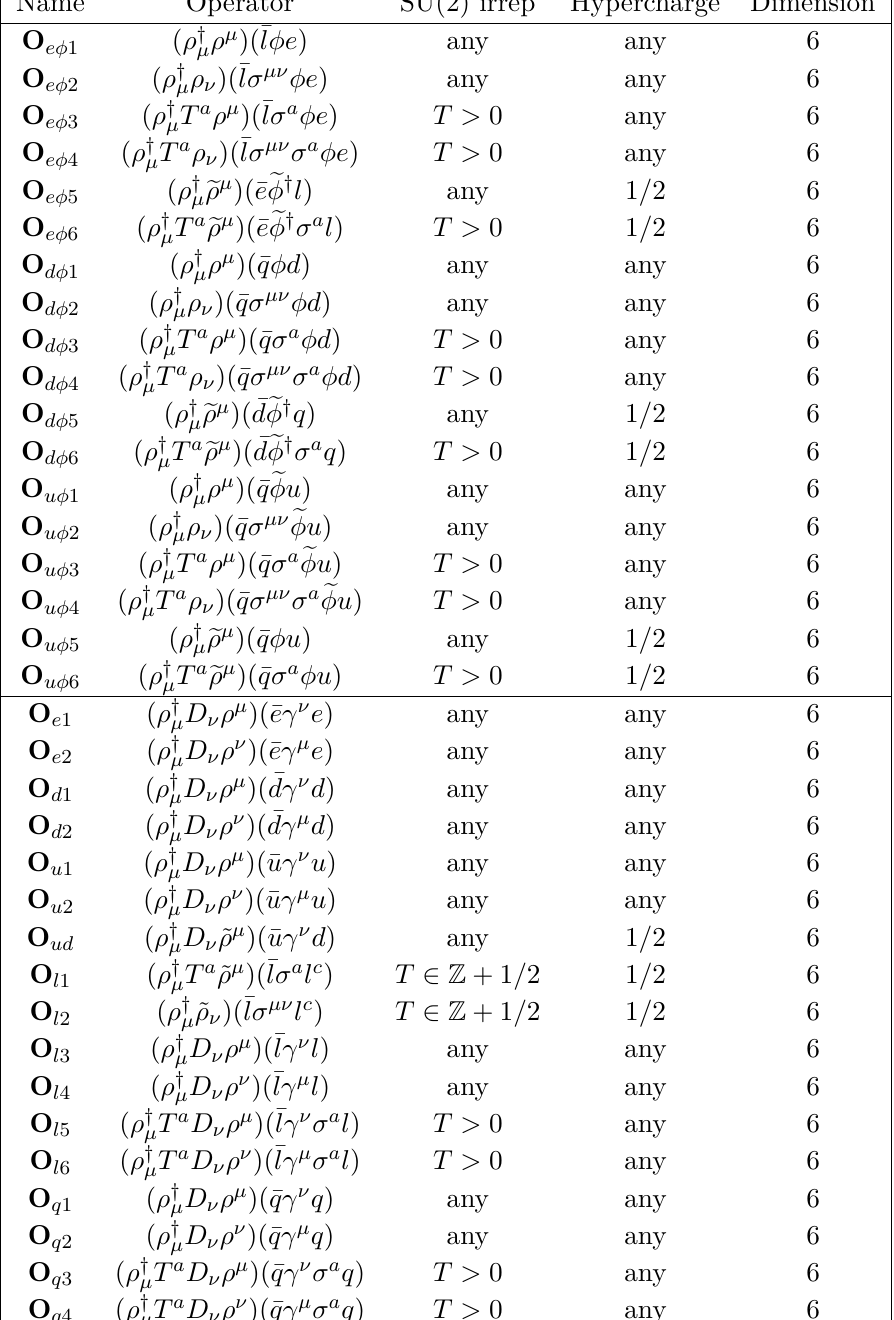
Table 8 . Basis of operators of dimension ≤ 6 with two vector DM multiplets and at least two SM